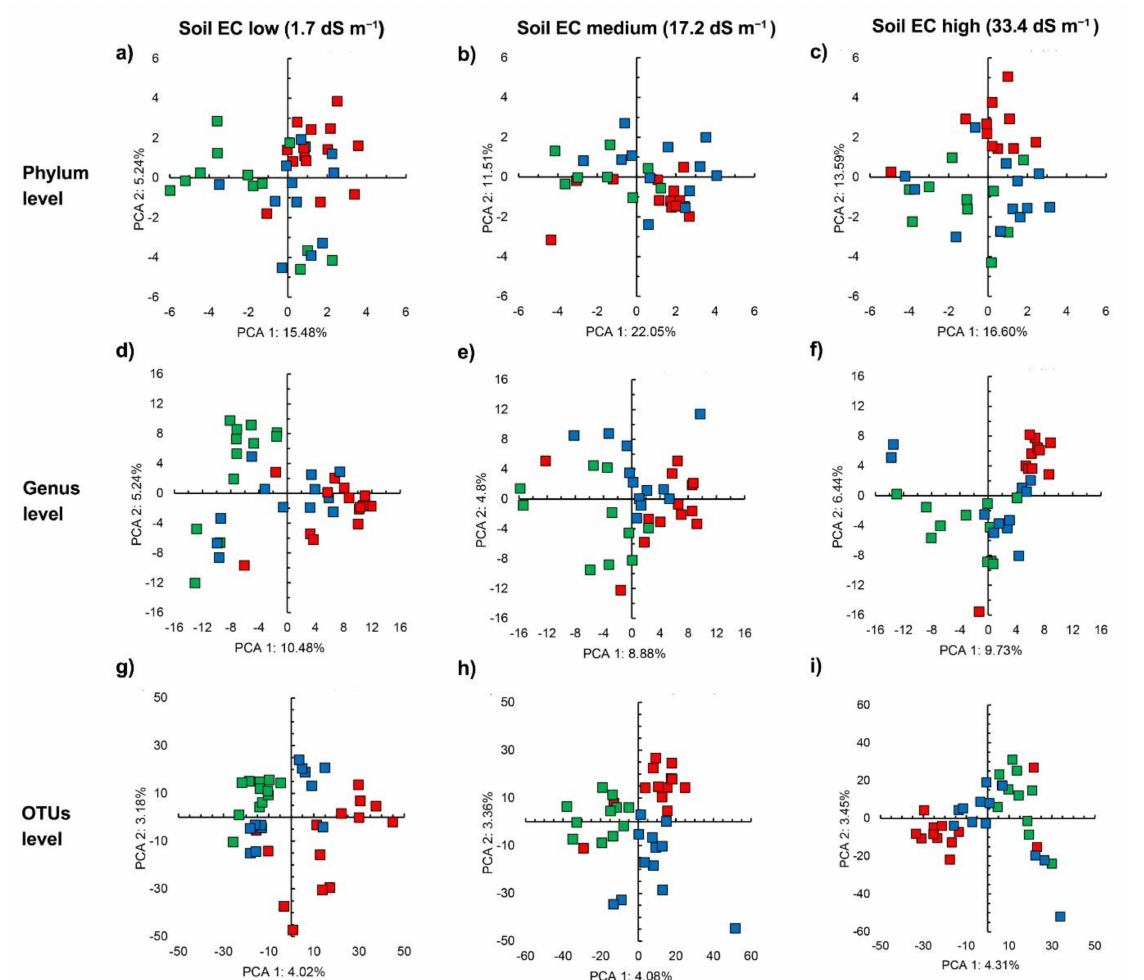
Figure 4. Principal component analysis (PCA) with the centered log-ratio transformed counts of bacterial groups in soil left unamended ( (cid:4) ), or amended with NDF fraction ( (cid:4) ) or young maize plants ( (cid:4) ) at the phylum taxonomic level in soil with ( a ) electrolytic conductivity (EC) 1.9 dS m − 1 , ( b ) EC 17.3 dS m − 1 , and ( c ) EC 33.4 dS m − 1 , at the genus taxonomic level in